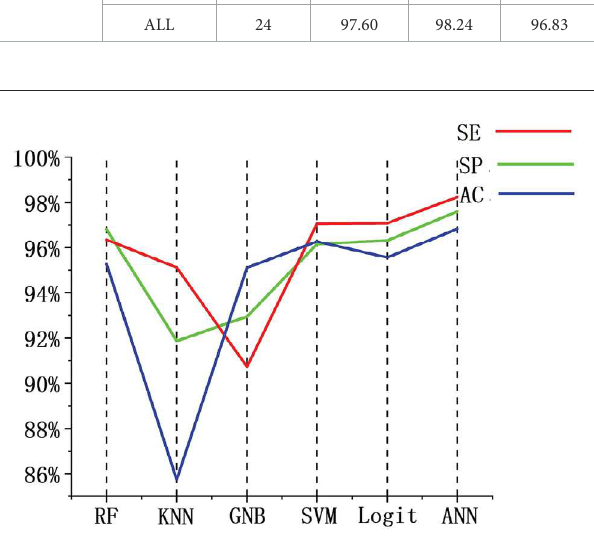
FIGURE11 Performance comparison of different classifiers based on